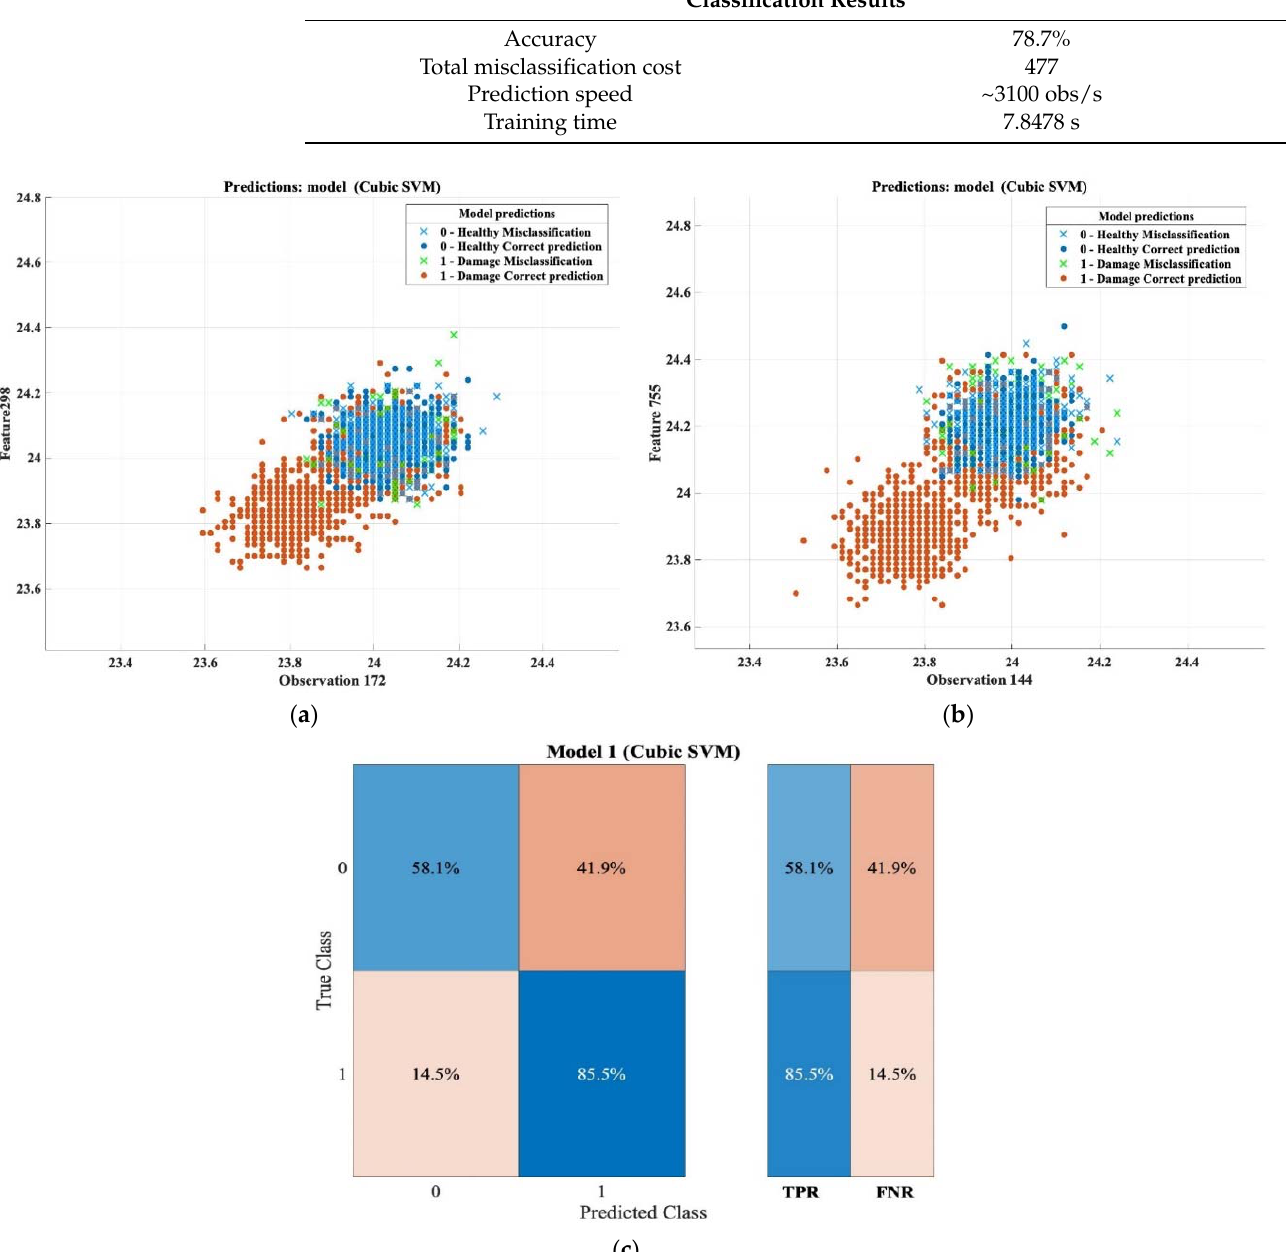
Figure 16. Classification results and confusion matrix for thick samples based on transmission mode. ( a ) Features patterns of classification results of the cubic SVM model (observation 172 vs. feature 298). ( b ) Features patterns of classification results of cubic SVM model (observation 144 vs. feature 755). ( c ) Confusion